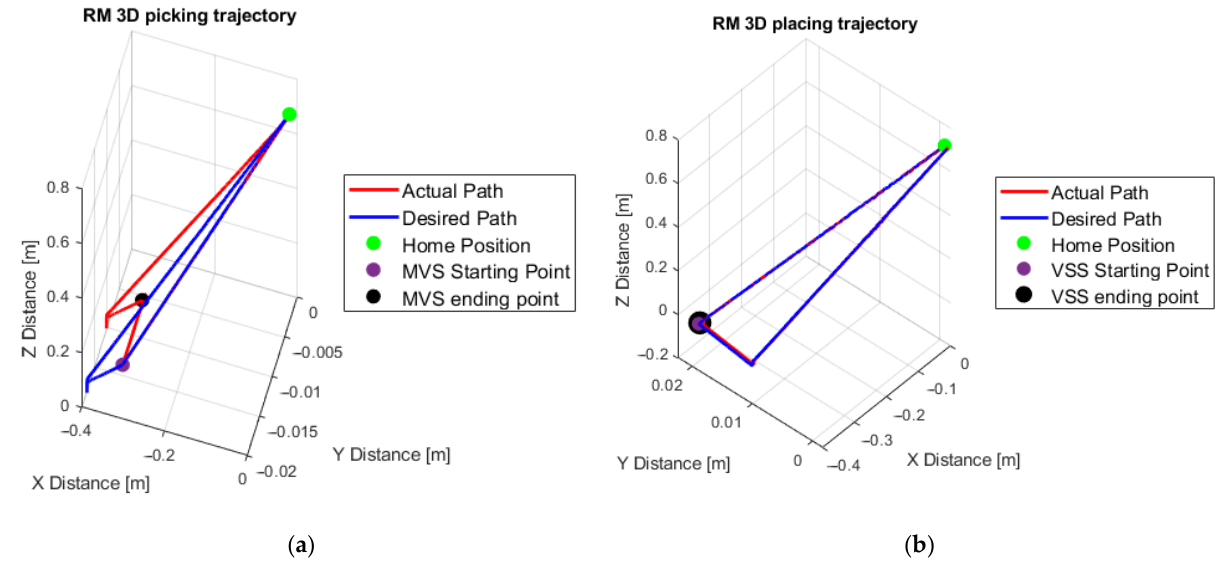
Figure 16. 3D Trajectories of the RM for ( a ) picking and ( b ) placing the workpiece.